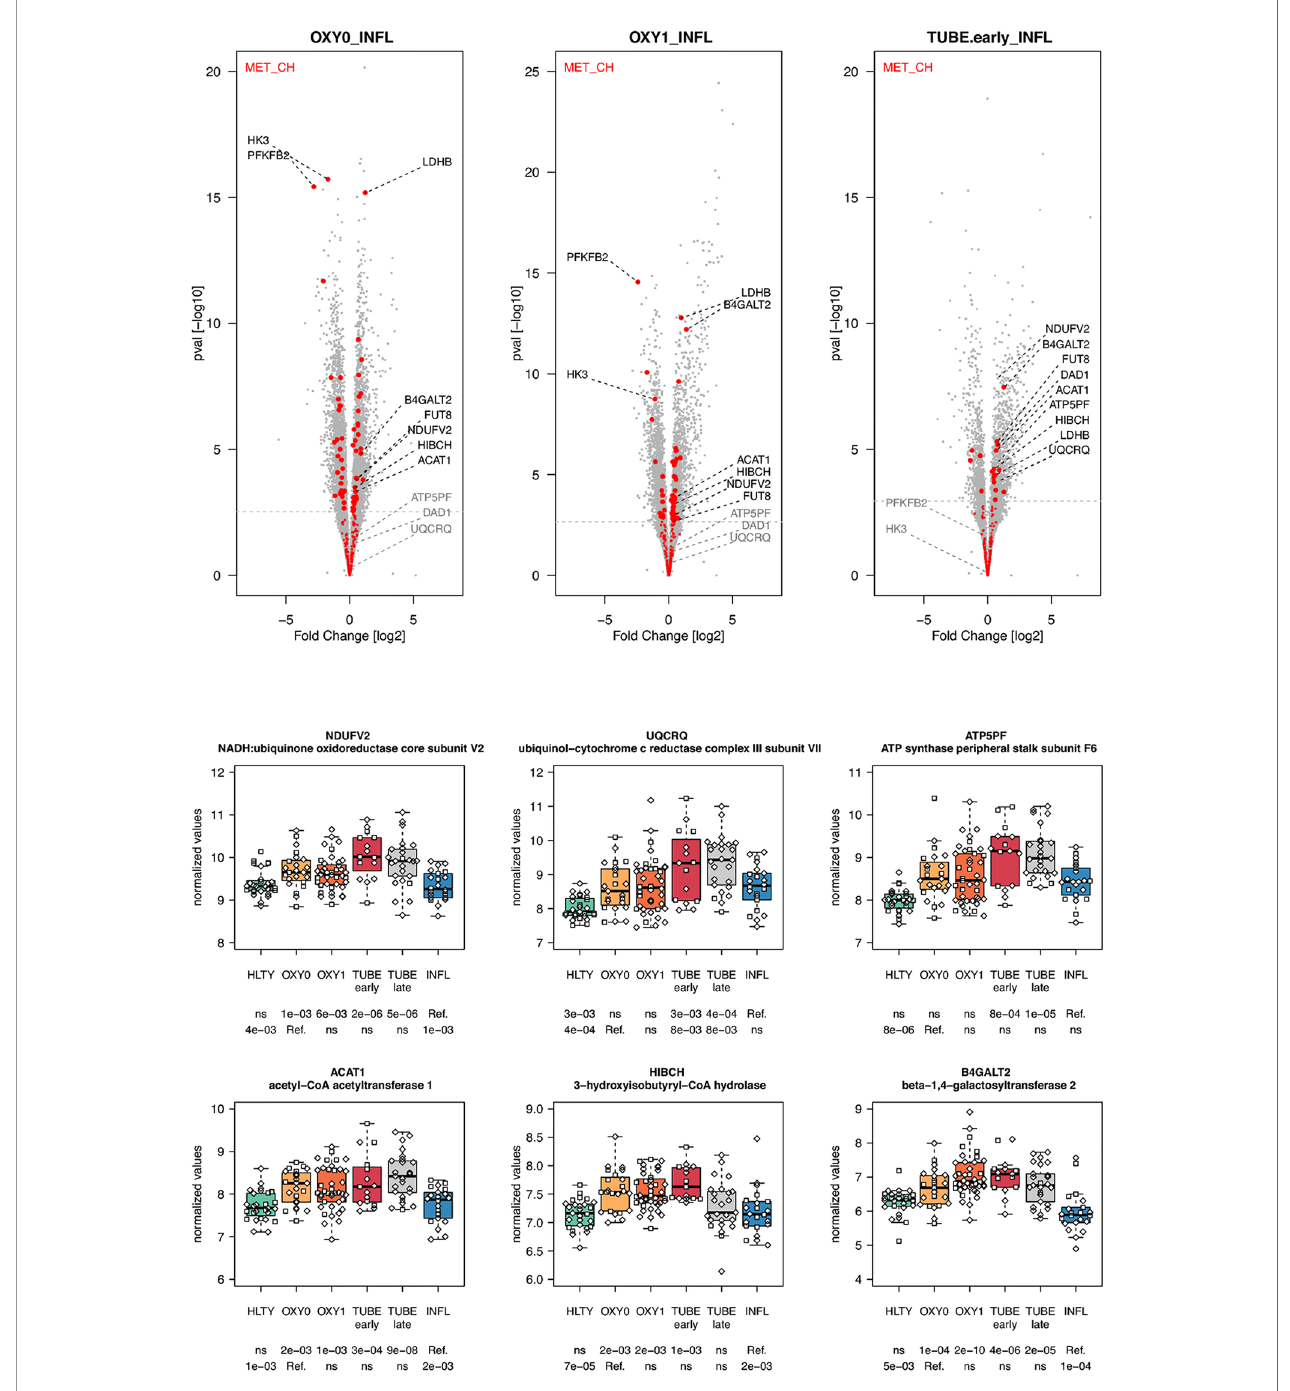
FIGURE 11 | Differentially expressed genes (DEGs) involved in cell metabolism. Upper panel: for each comparison indicated in the volcano plot header, the distribution of log2 fold changes and P-values of all detected genes is shown as gray dots. Red dots indicate genes involved in cell metabolism. Genes ’ sets are selected from different GO, REACTOME and/or KEGG pathways (see Supplementary Table 2 ). The dotted horizontal gray line indicates the limit under which – log10(P-value) becomes non signi fi cant once adjusted for multiple testing (adjusted P > 0.01). Lower panel shows detailed expression levels of selected genes involved in cell metabolism in the different groups of patients. Groups used for comparisons include SARS-Cov-2 infected patients (no oxygen support [OXY0], oxygen support [OXY1], intubation with sampling within 7 days [TUBE early] or >7 days [TUBE late] after hospital admission), In fl uenza virus [INFL] infected patients and non-infected controls [HLTY]. Adjusted P-values of pairwise comparisons between a reference group (Ref.) and another group are indicated below the x axis. Ref. is taken as [INFL] and [OXY0] on the fi rst and second line,